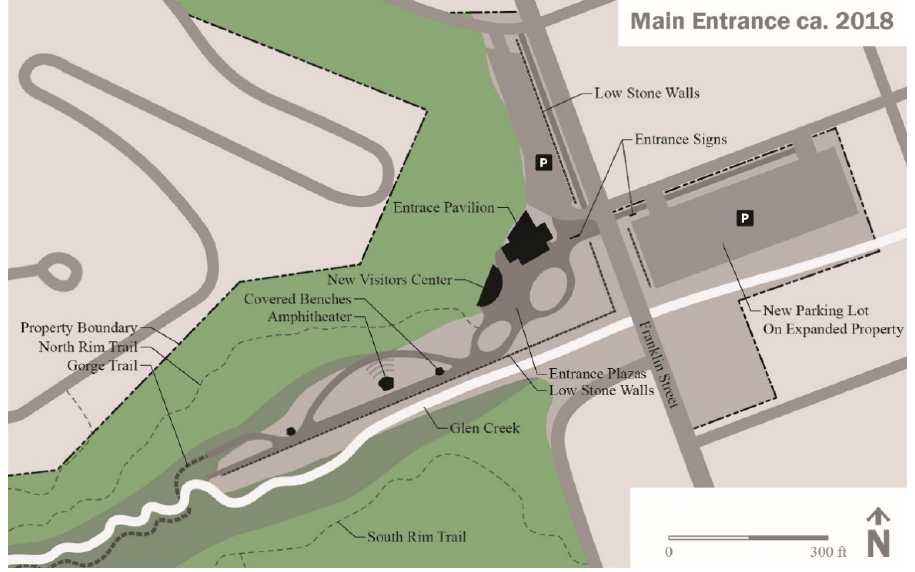
Figure 16. Plan of Main Entrance, ca. 2018, by author.